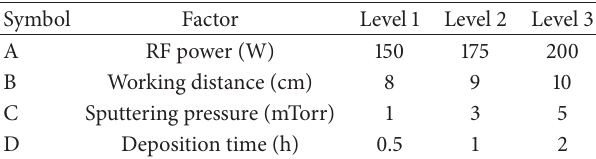
Table 1: Thedesignof theexperiment defines thedeposition param- eters of DLC films for each factor and level.